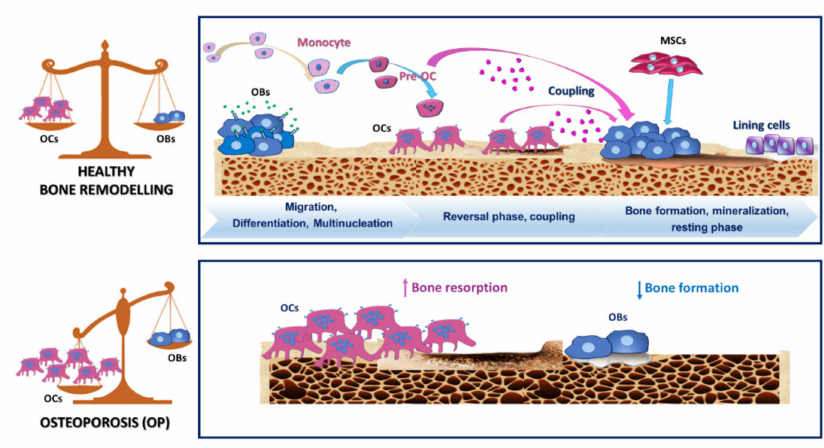
Figure 2. Graphical depiction of processes underpinning normal bone remodelling and osteoporosis (OP). The upper panel illustrates the classic phases occurring during normal bone remodelling, including migration of monocyte / macrophage precursors and di ff erentiation towards osteoclasts precursors (pre-OCs) and mature multinucleated osteoclasts (OCs). Bone remodelling also requires a cross-talk between osteoblasts (OBs) and OCs to ensure a proper equilibrium between bone resorption and production. The lower panel describes the altered balance between bone resorption and formation in favour of bone resorption by